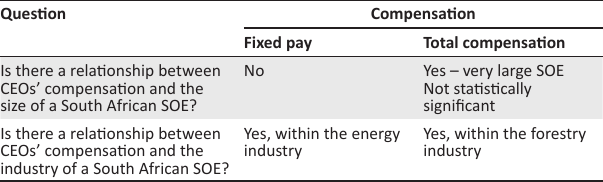
TABLE 9: Relationship between Chief Executive Officer compensation components , company size and industry .